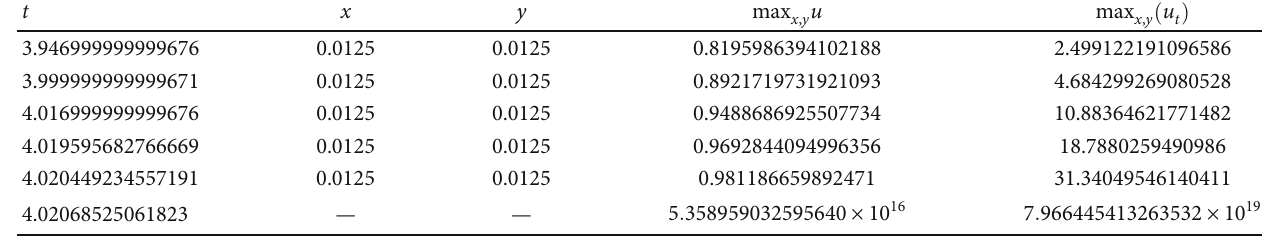
q = 0 : 8, b = b = − 2, α = β = t for x y